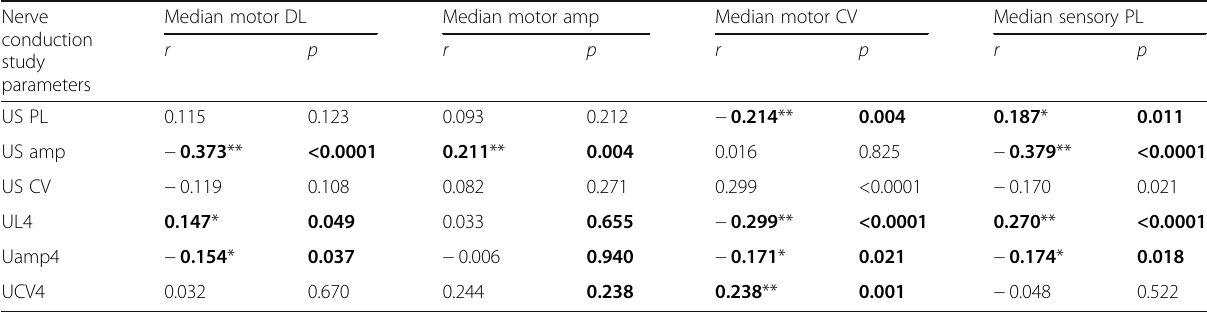
Table 4 Correlation between median motor distal latency and sensory peak latency and conduction studies of ulnar nerve recording D4 and